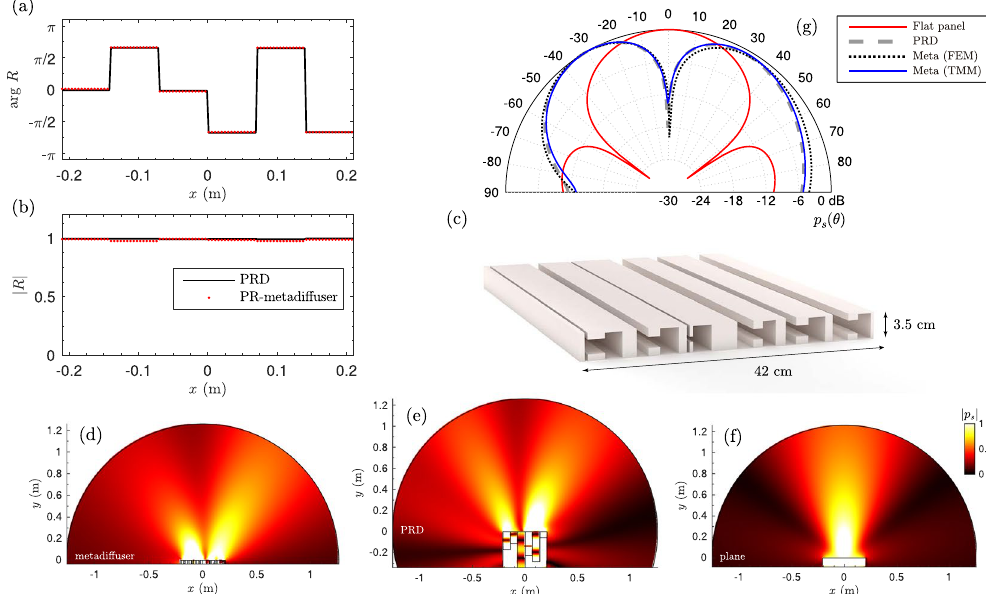
Figure 4. ( a ) Phase and ( b ) magnitude of the spatially-dependent reflection coefficient of a PRD (black line) and the PR-metadiffuser (red doted). ( c ) Scaled scheme of the metadiffuser using N = 6 and M = 1. ( d ) Near field pressure distribution at 1 kHz of a PR-metadiffuser with prime number P = 7 and thickness L = 3.5 cm ( e ) phase grating QRD of thickness L = 17.1 cm and ( f ) reference flat plane reflector. ( g ) Far-field polar distribution of the PR-metadiffuser obtained by TMM (continuous blue) and FEM (dotted black), the reference PRD (dashed-grey), and a plane reflector with same width of the diffusers (continuous red).